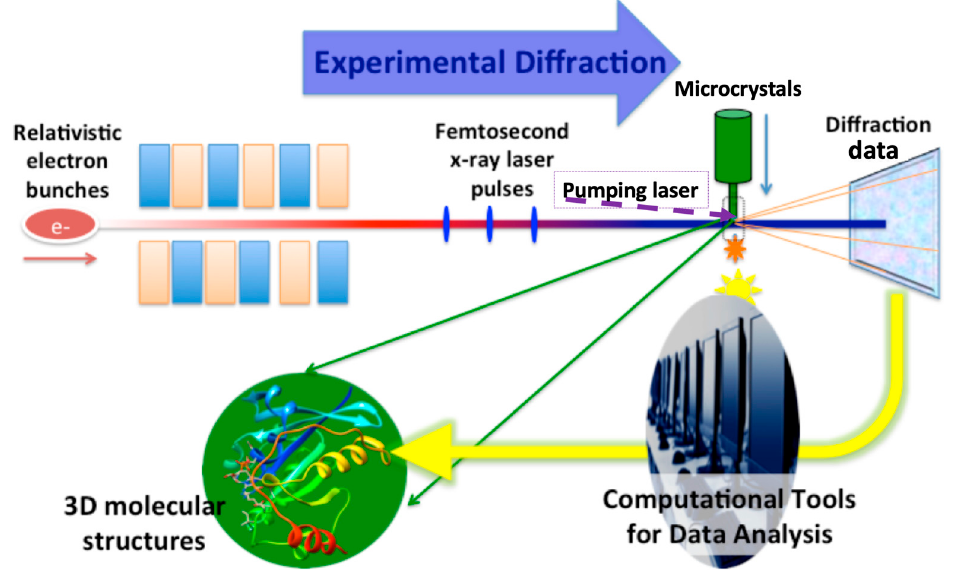
Figure 2. The workflow for protein crystallography at XFELs. The upper panel shows the forward process: high energy electrons produce coherent X-ray pulses that intercept microcrystals delivered via the injecting method, resulting in diffraction signals. The lower panel shows the data analysis and model interpretation, i.e., the inverse problem, to be solved using computational modeling methods. The pumping laser (purple dashed line) can be included for time-resolved experiments (Figure reproduced from [24] with permission).